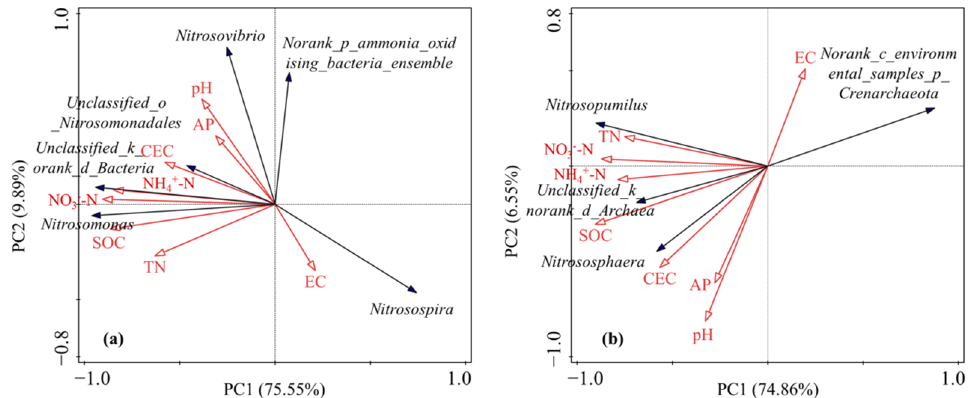
Figure 4. Redundancy analysis (RDA) diagram of the relationship between AOB ( a ) and AOA ( b ) community compositions (relative abundance of genus) and environmental factors. Table 5. Spearman’s rank correlations between the relative abundances of dominant genera of AOB and AOA, and nitrification rate, gene copies of amoA -AOB and amoA -AOA, and the soil basic properties ( n =